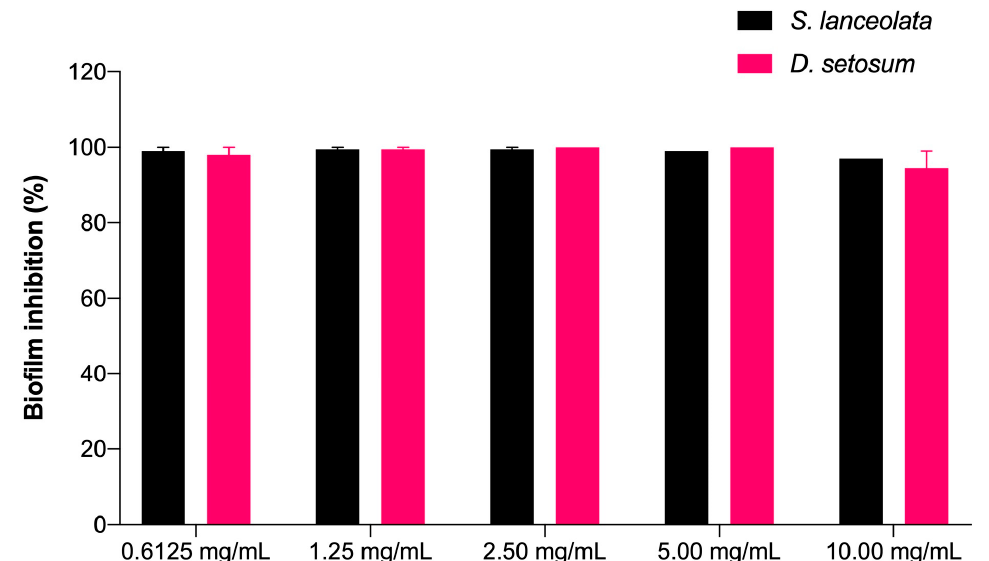
Figure 9. The percentage of P. aeruginosa biofilm inhibited by D. setosum and S. lanceolata crude extract with respect to concentration in antifouling assay. Data were presented as mean ± SEM ( n = 3).